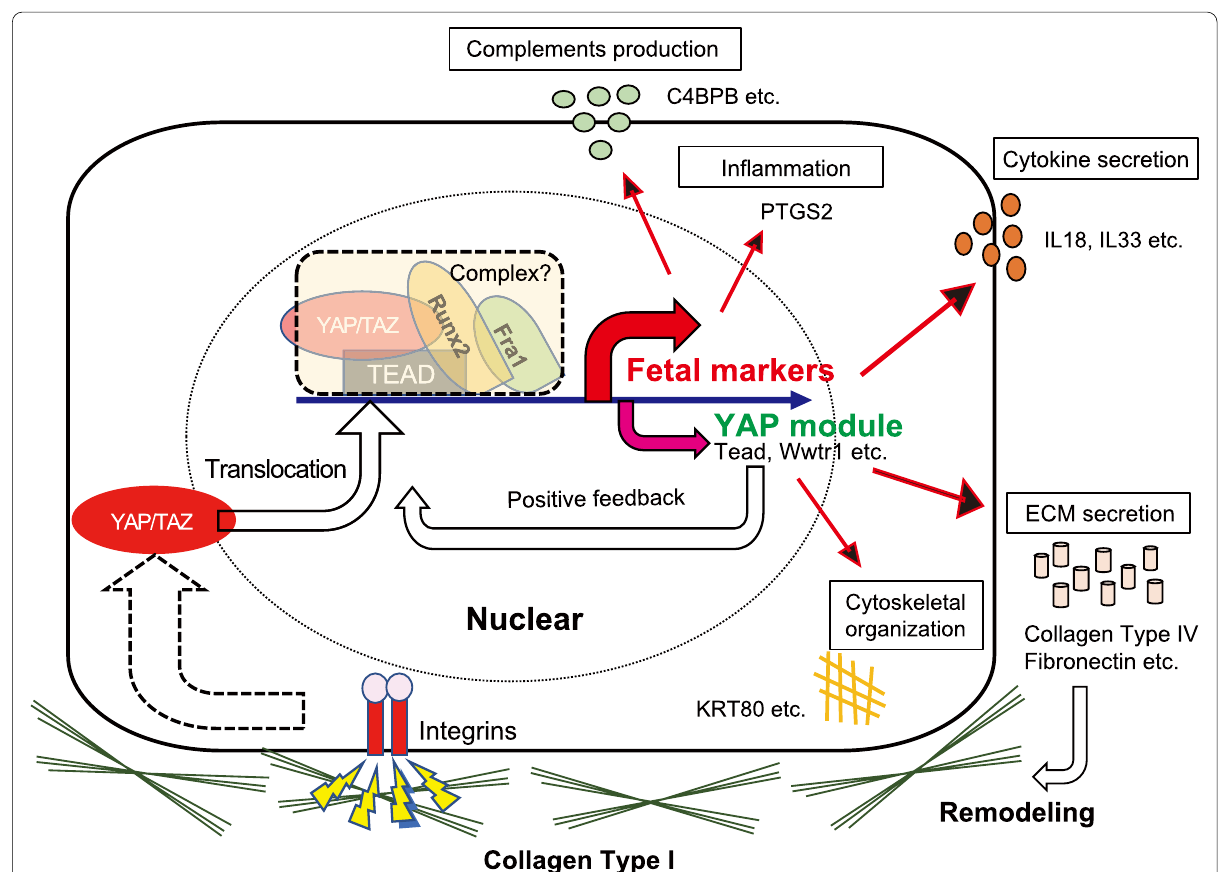
Fig. 7 Overview of collagen type I‑dependent epithelial cell plasticity. Schematic illustration how collagen type I triggers epithelial cell fate conversion in both mouse and human cells is presented. Collagen type I stimulates integrin a2b1 heterodimers, subsequently promotes nuclear translocation of YAP/TAZ. In the nuclear, YAP/TAZ coordinates with Fra1 and Runx2 to induce fetal marker genes such as Ly6a/Clu/Tacstd2 in mouse and TACSTD2 in human. Genes involved in YAP module such as Tead/Wwtr1 are also induced, which will be subsequently recruited into the cascade to form a positive feedback loop. Downstream of the cascade, various responses are initiated, including the production of inflammatory molecules PTGS2, cytokine secretion such as IL33 and IL18, cytoskeletal organization with several different types of keratins such as KRT80, complements production such C4BPB, and ECM secretion such as collagen type IV and fibronectin. ECM secretion will subsequently remodel the ECM‑niche and will influence the